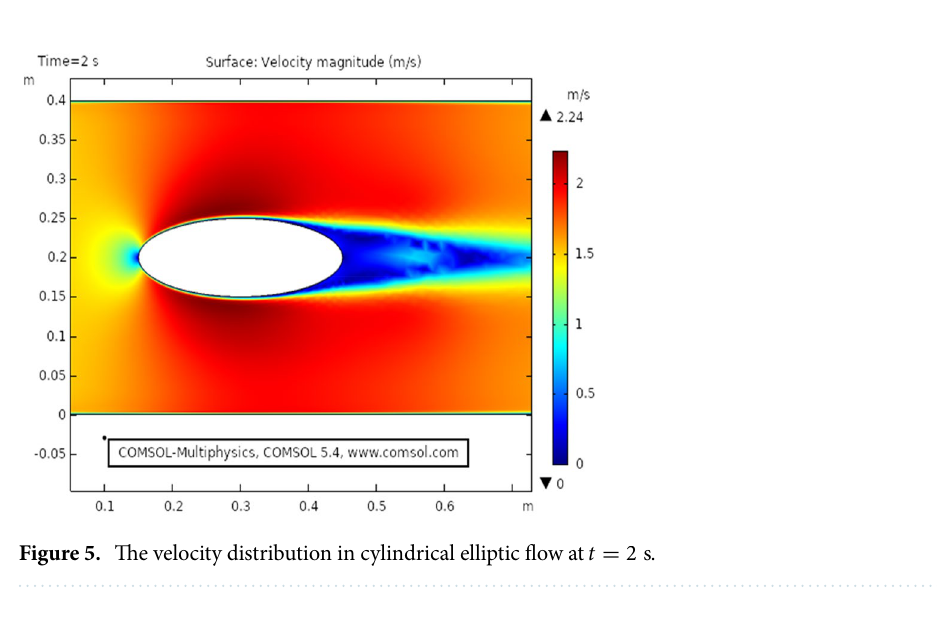
Figure 4. The velocity distribution in cylindrical circular flow 32 at t = 7 s .